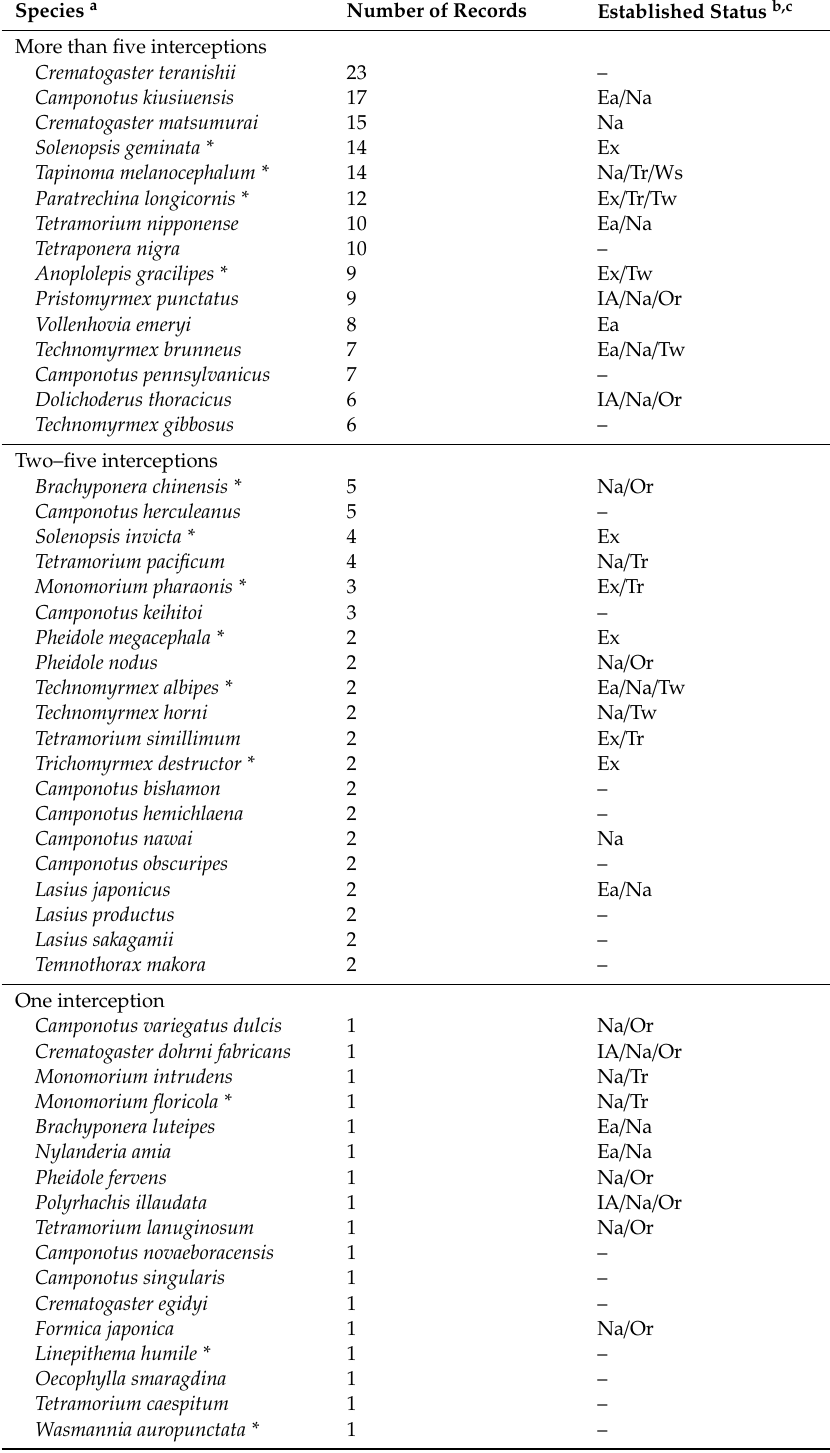
Table 1. List of ant species intercepted at the Taiwanese borders based on the database “Quarantine Information System” established by the Bureau of Animal and Plant Health Inspection and Quarantine (BAPHIQ) from 2011 to